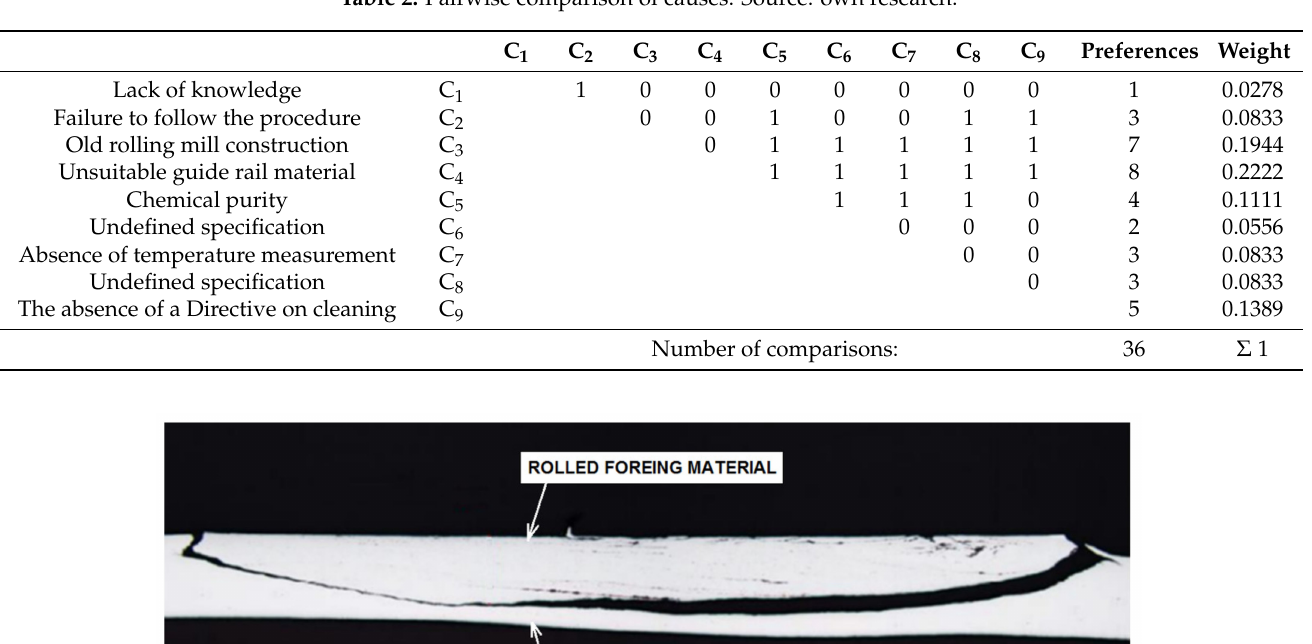
Table 2. Pairwise comparison of causes. Source: own research.